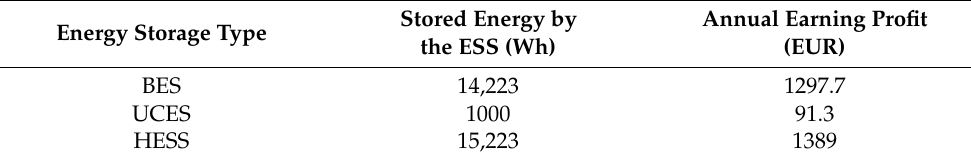
Table 3. The amount of daily stored energy and earning profits of each ESS.